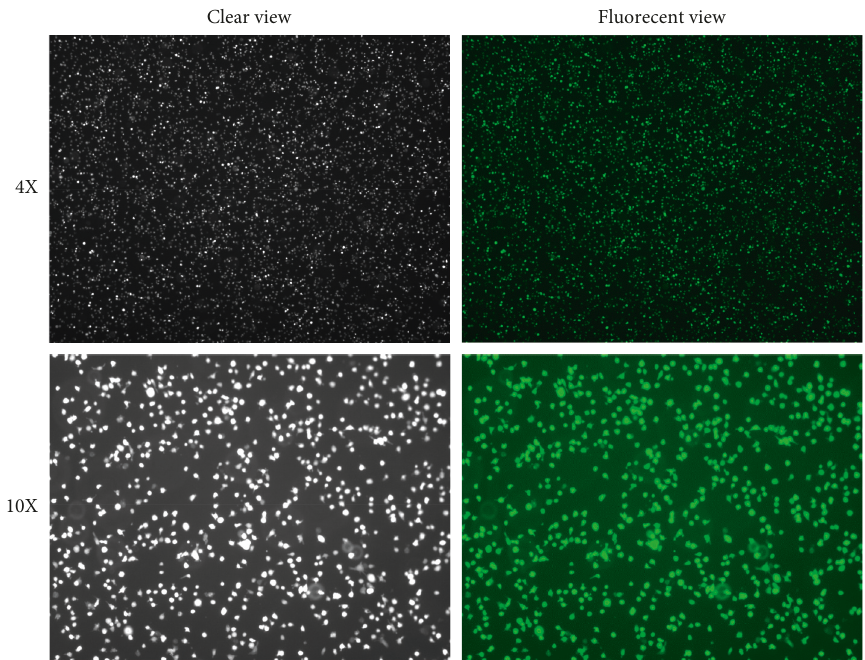
Figure 2: Clear and fluorescent views of cell tracker stained THP-1 cells ready for experiments with 4X or 10X magnification.